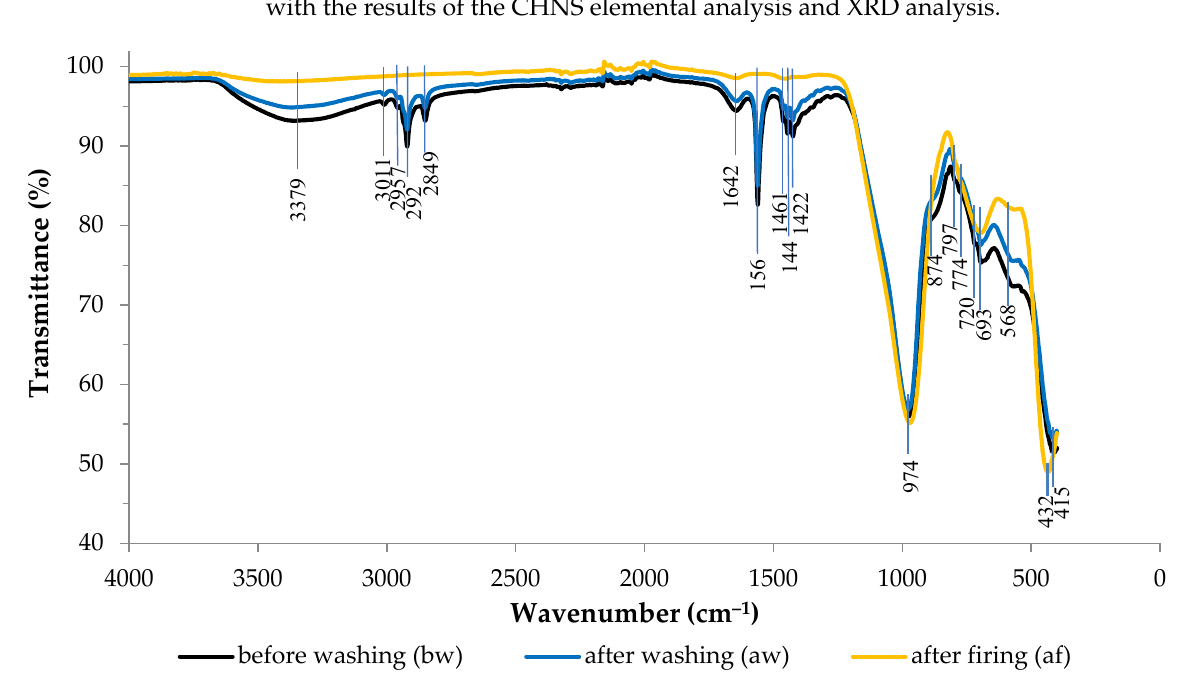
Figure 3. XRD patterns of sample S-4.5 (a) before washing, (b) after washing and (c) after firing (q: